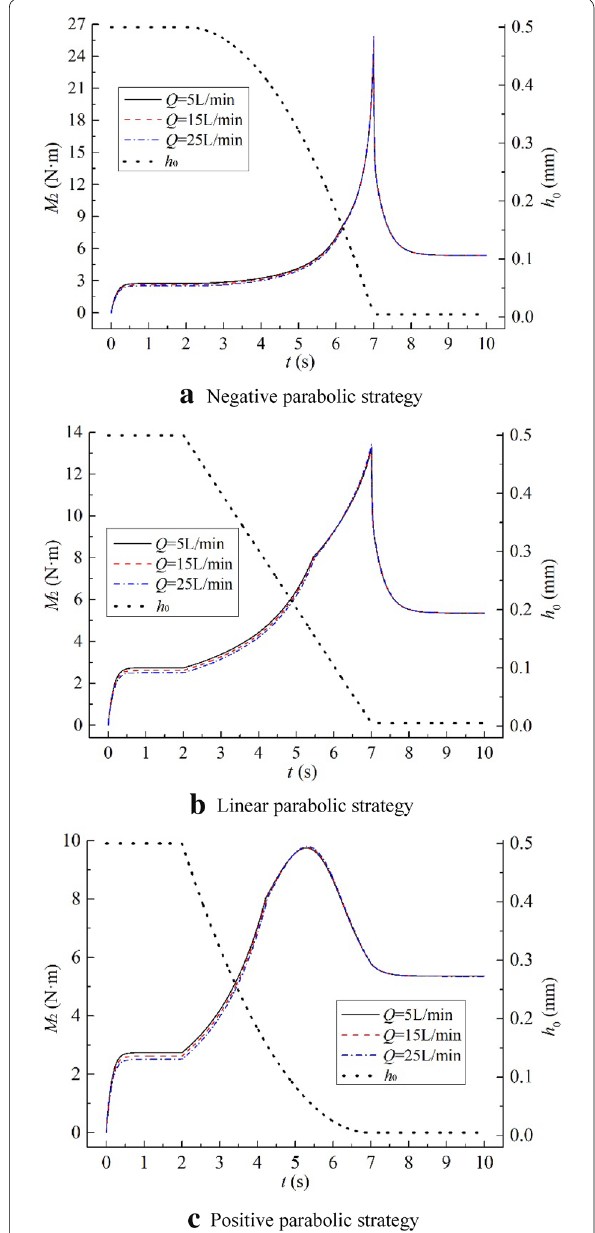
Figure 8 Variations of M 2 under different throughflow rate